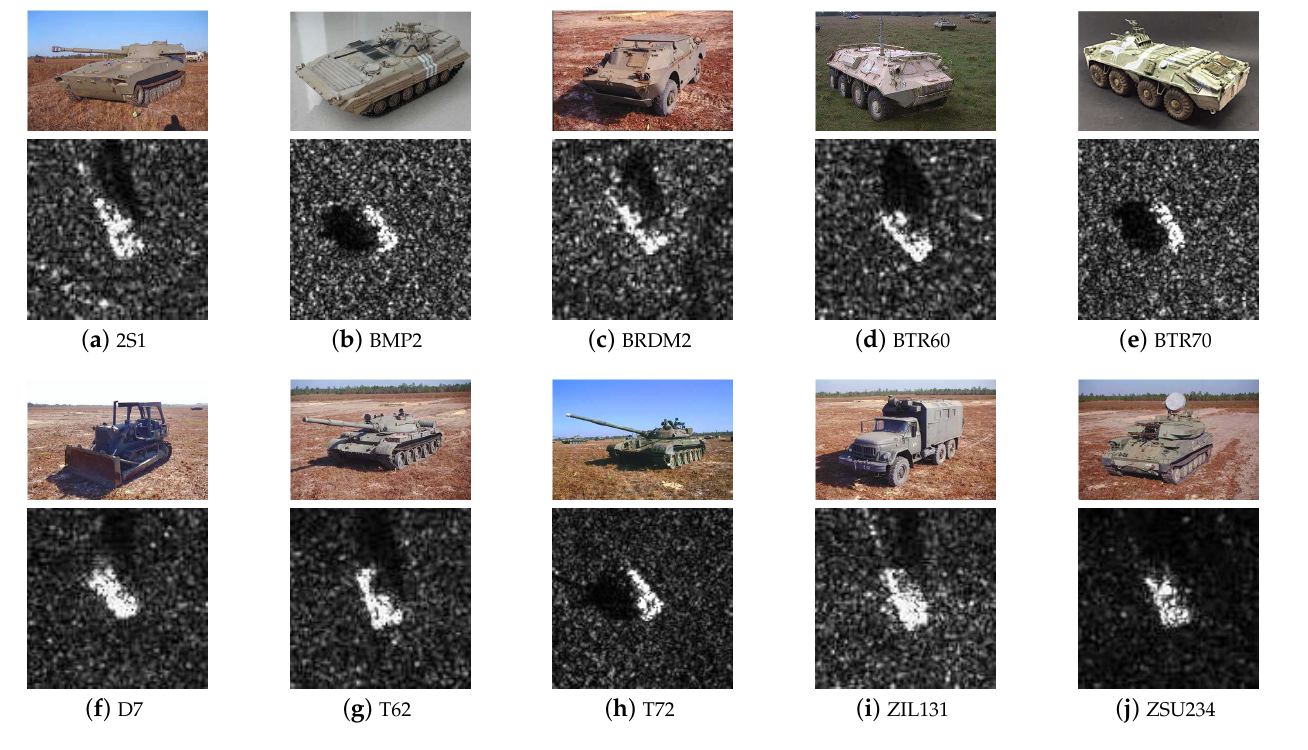
Figure 5. Optical images and corresponding SAR images of MSTAR